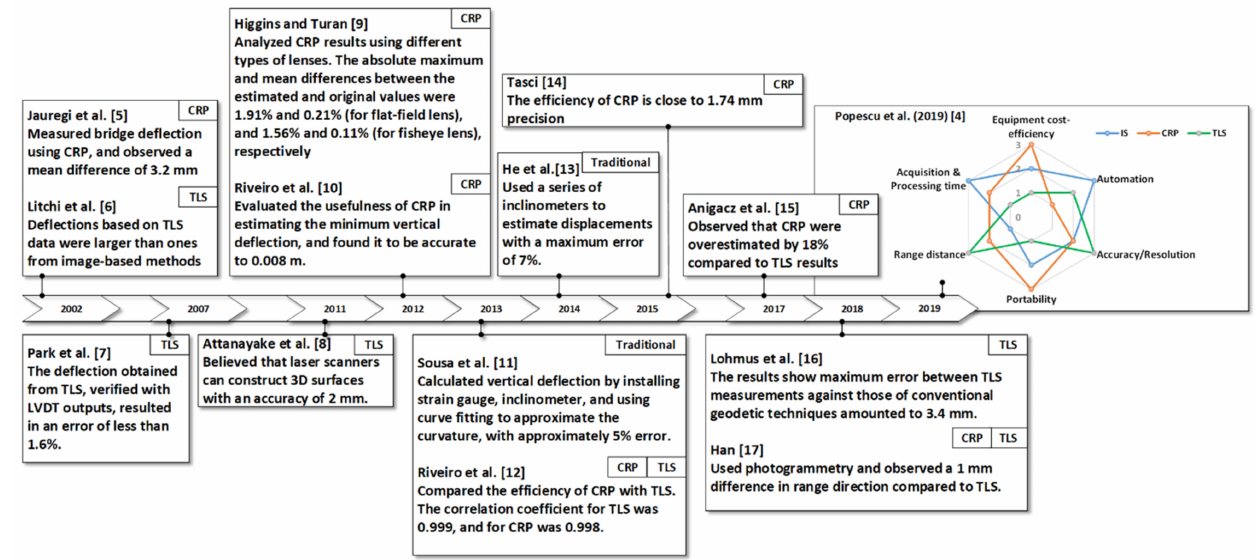
Figure 1. Review of the obtained accuracy from optical and traditional methods over the last twenty